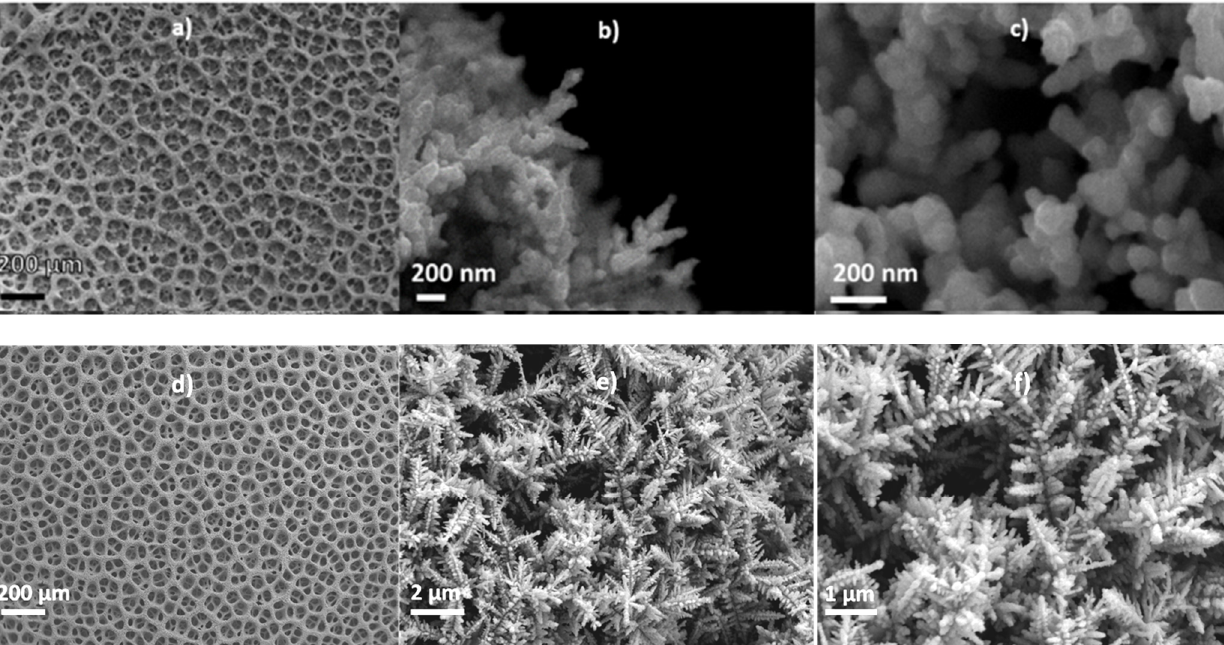
Figure 9. SEM images of CF-18H ( a – c ) and of CF-18H-100U ( d – f ) after 35 min of CO 2 electrolysis at − 0.83 V vs. RHE in 0.1 M of KHCO 3 and 40 mL/min CO 2 .